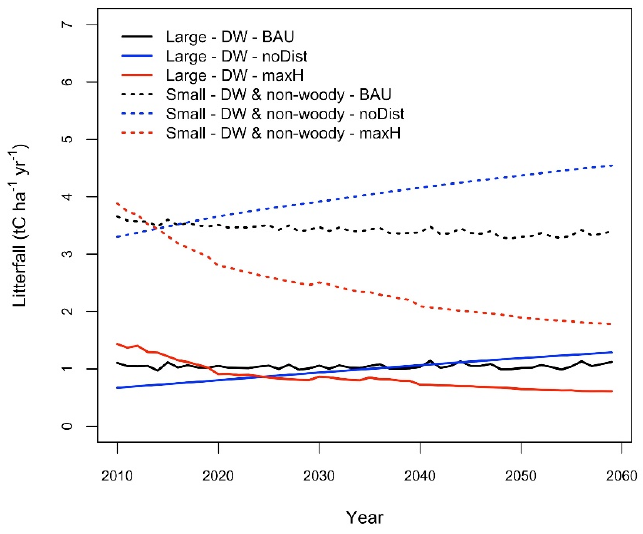
Figure 7. The litterfall dynamic split on large dead wood (diameter > 10 cm) and small-wood and non-woody components (diameter < 10 cm, foliage, fine roots) for the three scenarios. The litterfall shares linked to silvicultural interventions were rather small. The large wood fractions, i.e., large dimensions of stem wood with commercially relevant dimen- sions, represented only 15% under BAU. For the other two scenarios, it was much smaller, given the total harvesting of available biomass (under maxH) or limited to the contribu- tion from natural mortality (under noDist). In fact, the harvest-based demand led to silvi- cultural interventions on only approximately 4% of the total forest area annually. On av- erage, it represented an area of 60 kha that was a subject to final cuts and 200 kha that was subject to thinning operations annually, which explains the low contribution of silvicul- tural interventions to total litter input. 3.5. Projections of Soil Total C Stock and Dynamics of the Annual C Stock Change Generally, both models simulated a similar development in the total C stocks within different scenarios (Figure 8a). In BAU, there were very few changes over time (Figure 8b). Such a flat dynamic under BAU shows both consistent litterfall input and consistent decomposition for the simulated period compared to initialization (as shown in Figure 6). The C stock was the highest by the end of the simulation period in the noDist scenario. By opposition, maxH scenario showed the smallest one. The short time increase and, respec- tively, the decrease of C stocks in the first two decades simulated under maxH and noDist show primarily an unbalance of litterfall inputs between simulation compared to initiali- zation.